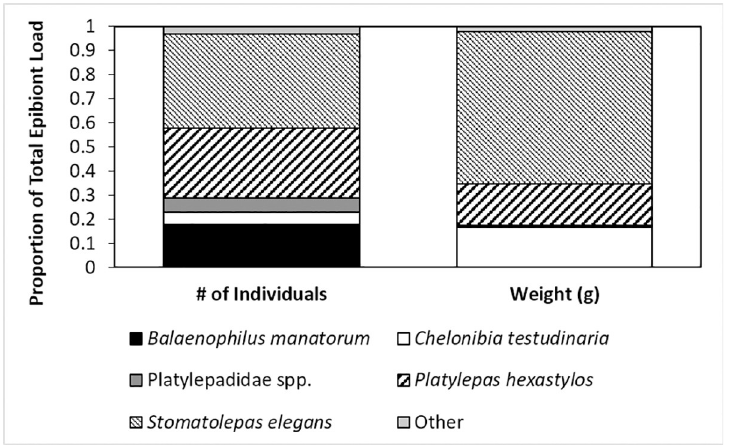
Fig 3. Proportion of the five main epibiont species relative to the total epibiont load found on the entire body of olive ridley sea turtles. The left graph represents % abundance and the right graph represents % total biomass.